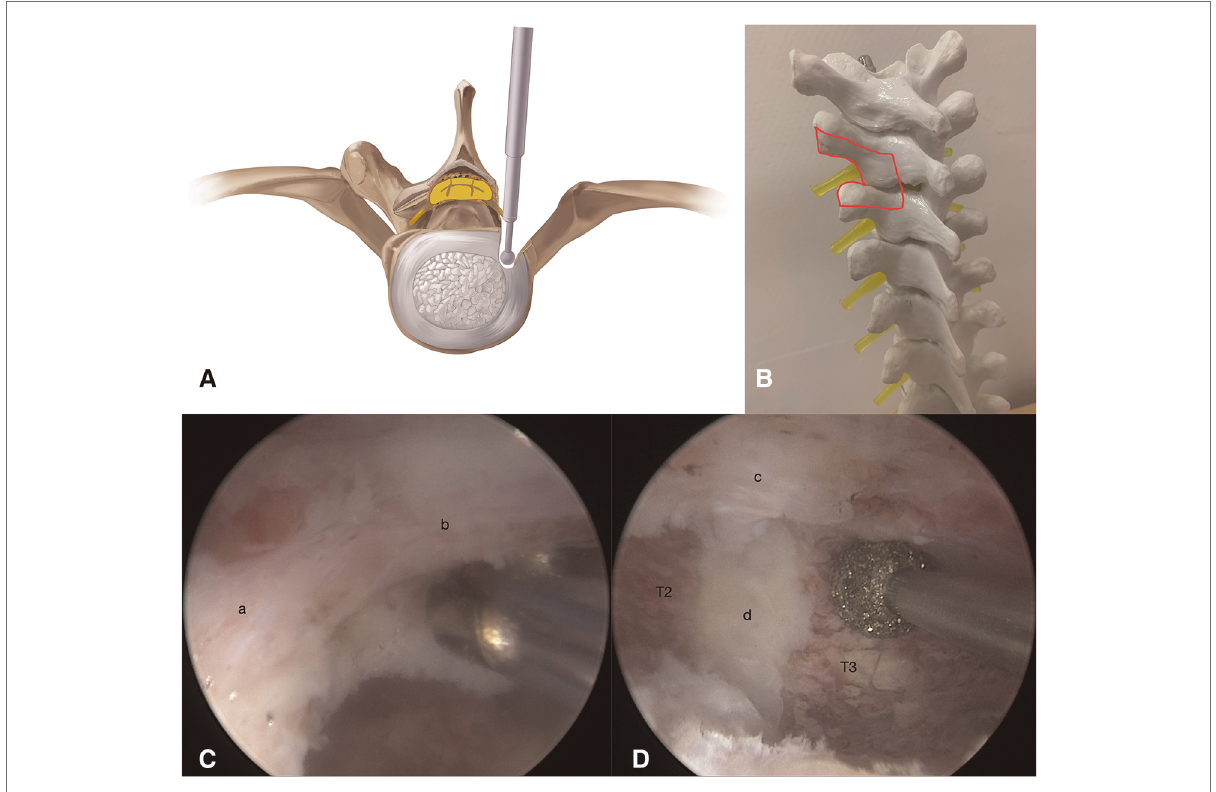
FIGURE 3 ( A,B ) Illustration showing the drilling of ipsilateral lamina, left facet joint, partial transverse processes, and pedicles of T2 and T3 by step 1. ( C,D ) Exposure of T2 intercostal nerve (a), dural sac (b), TOPLL (c) and intervertebral disc of T2 – T3 (d).